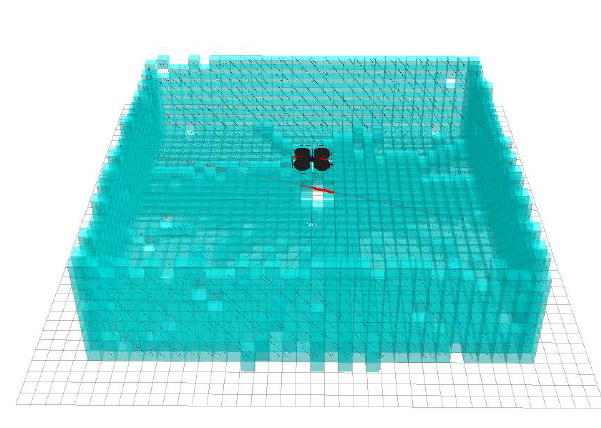
Figure 5: An exemplary grid-based map of a simulated environ- ment.